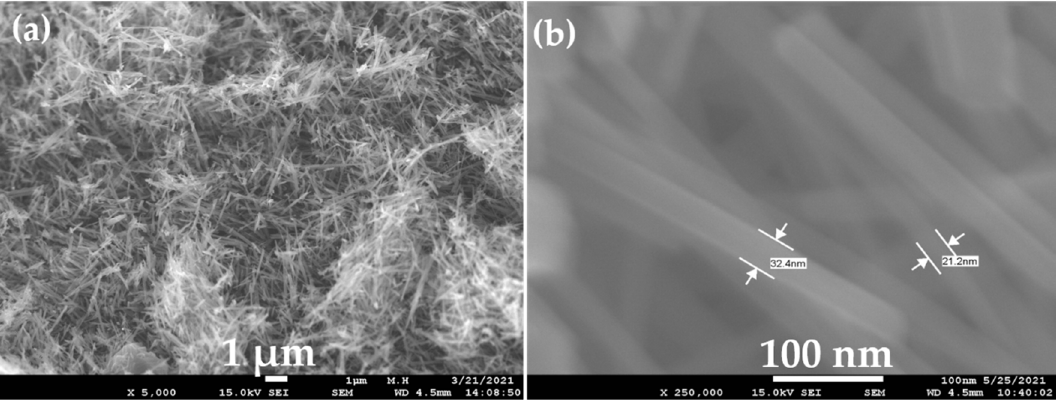
Figure 2. ( a ) Low and ( b ) high resolution FESEM images for α -MnO 2 nanowires. The qualitative element composition and the distribution of the hydrothermally syn- thesized α -MnO 2 nanowires were analyzed through EDS spectrum and elemental mapping images, respectively (Figure S1). Selected area electronic FESEM image (Figure S1a) and EDS spectrum (Figure S2b) with inset representing the atomic and weight percentages of Mn and O in the sample indicate the presence of only Mn and O signals. The presence of only Mn and O elements in the EDS spectrum provides strong evidence for the suc- cessful formation of the MnO 2 as well as the excellent purity of the sample. EDS element mapping images for the MnO 2 nanowires are shown in Figure S1c,d, which indicate the homogeneous distribution of the constituent elements evenly throughout the matrix of the MnO 2